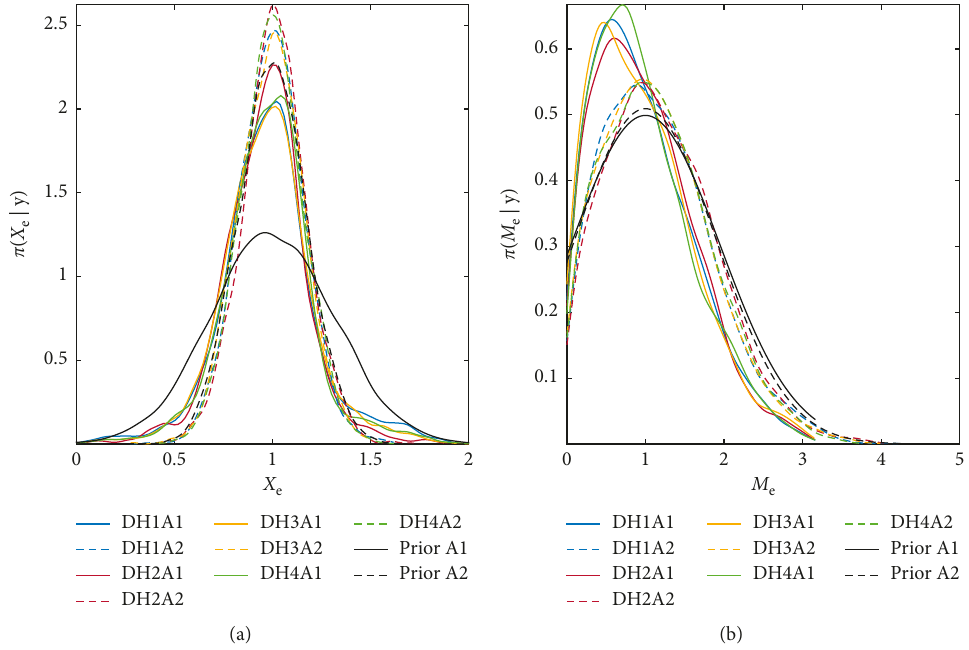
Figure 9: Anomaly scenarios A1 and A2. Prior covariance matrix with λ